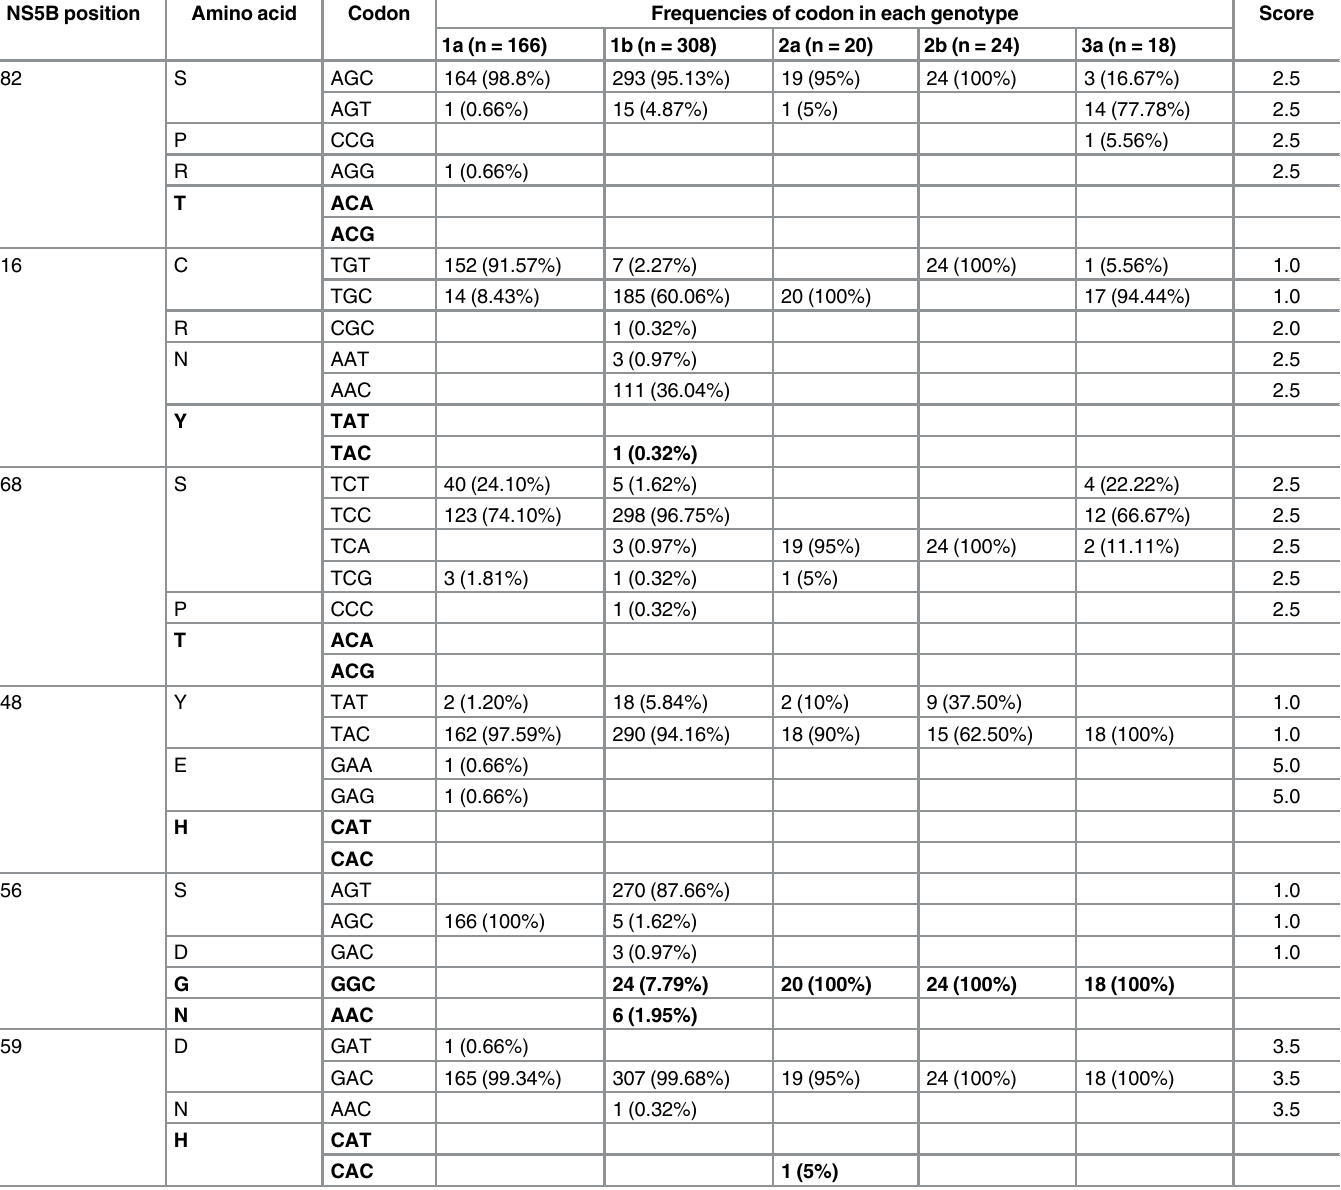
Amino acids and nucleotides in bold are associated with resistance. Only codons with at least one sequence found in the database are shown, except for the resistance amino acids. The score was calculated considering the minimal change necessary to generate a resistant